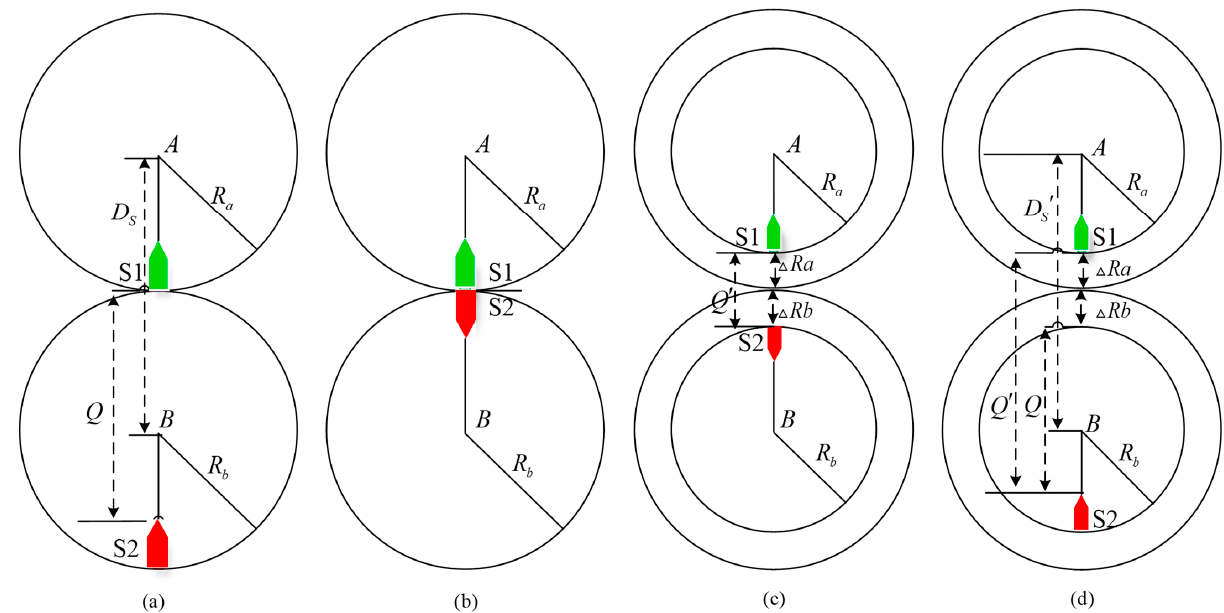
Figure 5. Schematic diagram of the safety distance model of anchoring ships. ( a ) The two anchoring ships with synchronous motion. ( b ) The two anchoring ships without synchronous motion. ( c ) The safety margin of the two anchoring ships with synchronous motion. ( d ) The safety margin of the two anchoring ships without synchronous motion.